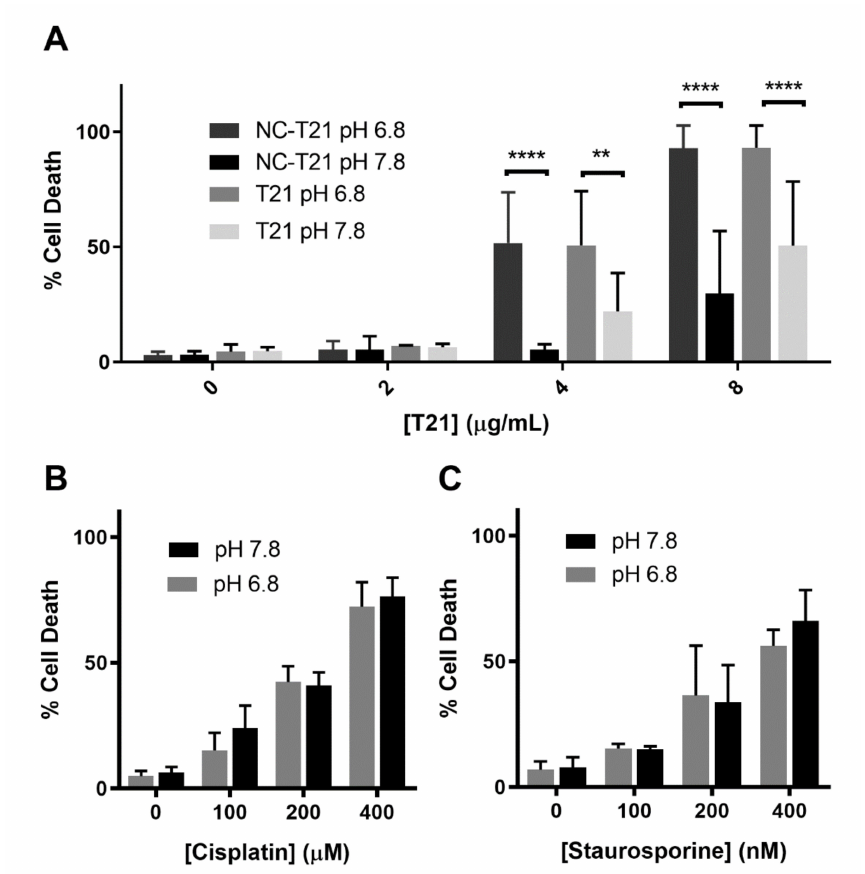
Figure 6. Effect of pH on cell death. A549 cells were incubated with increasing concentrations of ( A ) free (T21) or encapsulated T21 (NC-T21), ( B ) cisplatin, and ( C ) staurosporine at pH 6.8 and 7.8 for 24 h. Dead cells were counted by trypan blue staining, average ± SD of 3 independent experiments is represented. ** p > 0.01, **** p >